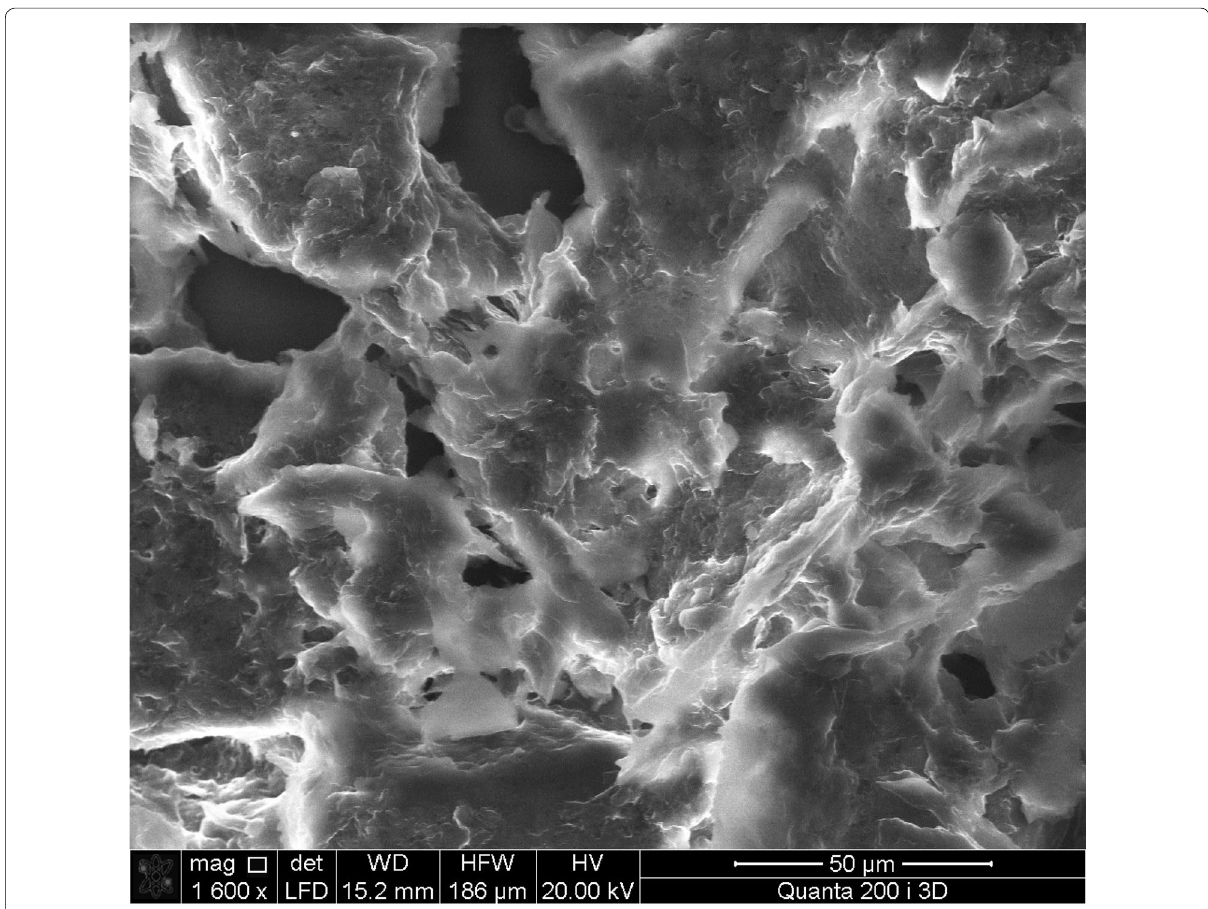
Fig. 8 SEM images of dried flakes of bacterial cellulose synthesized by immobilized